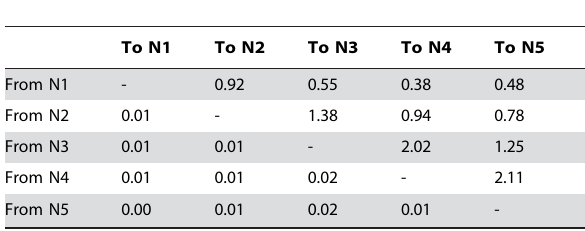
The left column indicates what the source neuron and the top row indicates the target neuron. For example, to locate the influence of neuron 2 on neuron 3 a value of 1.38 is reported in entry From N4, To N1.